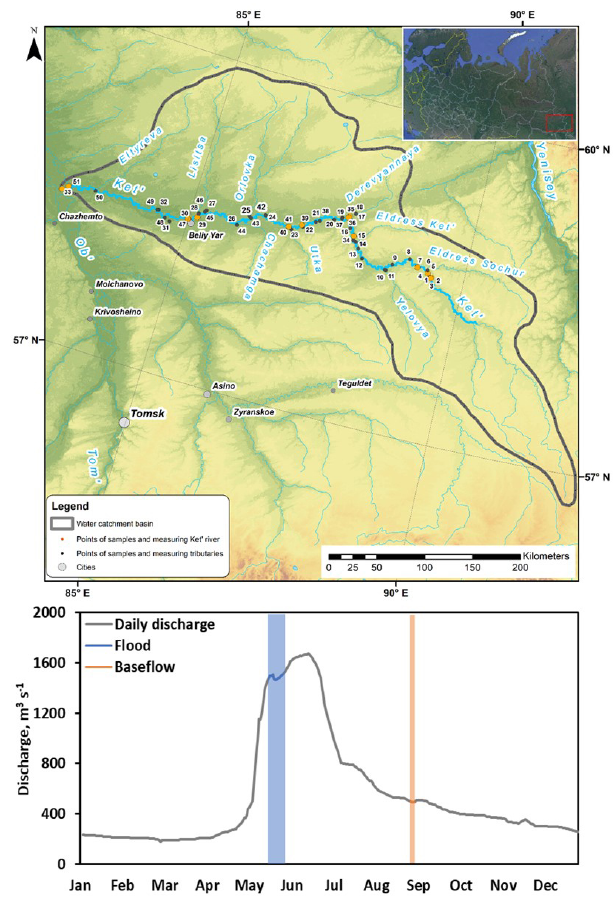
Figure 1. (a) Map of the studied Ket River watershed with continuous p CO 2 measurements in the main stem (credit map: Yu Kolesnichenko). (b) Daily discharge ( Q ) at the gauging station of the Ket mouth, Rodionovka, in 2019. Highlighted in blue and orange are two sampling campaigns of this study, spring flood and summer–fall